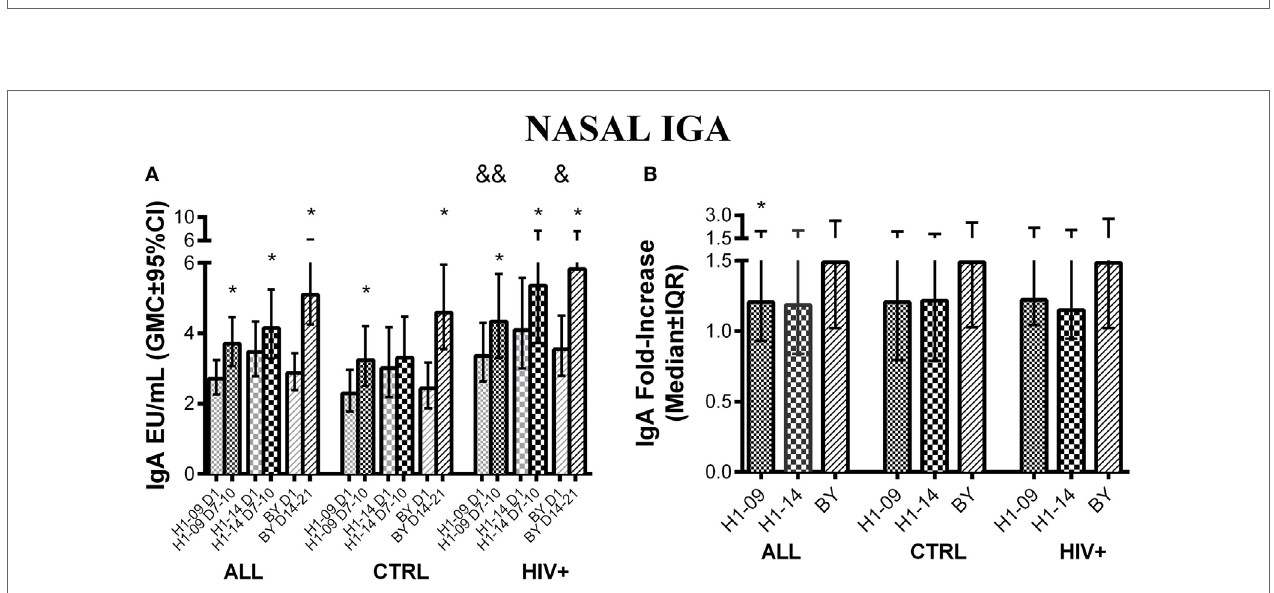
FigUre 5 | nasal iga antibody responses to laiV4 measured by elisa . The data were derived from 45 HIV-infected and 55 uninfected individuals. (a) Absolute responses in each group of participants, as indicated below the abscissa, at V1 (before vaccination) and at the maximum response, which was V3 (7–10 days after vaccination) for H1N1 viruses and V4 (14–21 days after vaccination) for BY. The viruses are indicated in the labels of the abscissa. Asterisks (*) indicate significant differences between pre- and post-vaccination. And symbols (&) indicate significant differences between HIV-infected and uninfected participants. (B) Fold-increases from pre- to post-vaccination. Asterisks (*) indicated significant differences between H1N1-09 and